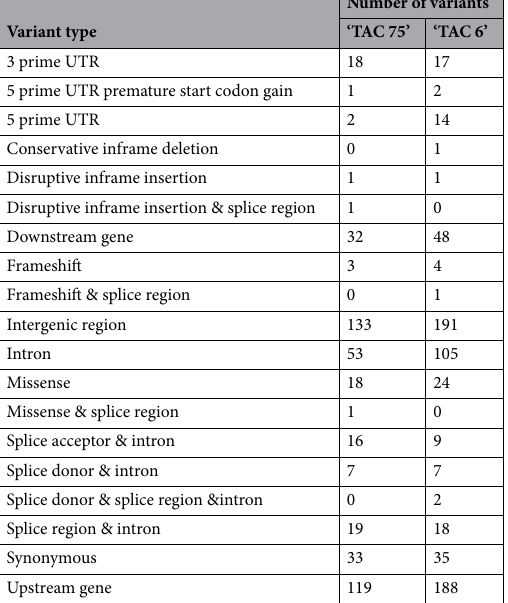
deleterious effect on proteins. The detail of total number of identified variants listed in Table 2. Mutant charac- terization indicated the presence of EMS induced specific mutations in RING protein genes identified in high (‘TAC 75’) and low (‘TAC 6’) mutant lines making them unique for the variants. One of the previous studies from our lab 6 , has also characterized the two mutant lines for key enzymes GBSSI and SBEII responsible for